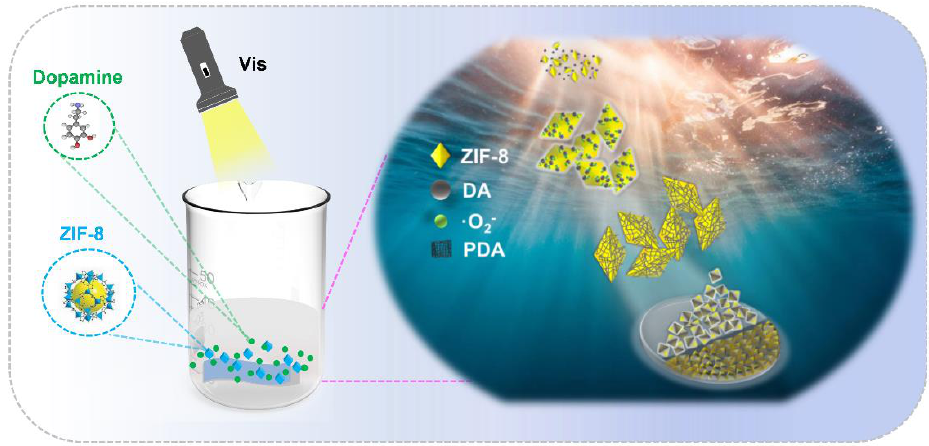
Figure 1. Schematic representation of rapid assembling MOF composite membrane strategy.